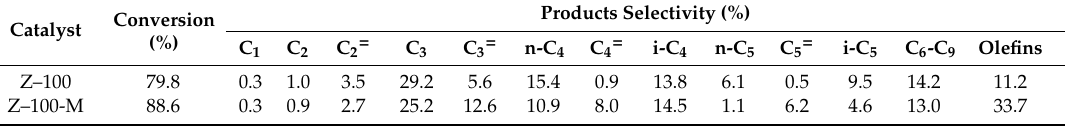
Table 4. The conversion of the catalytic cracking of n-decane and the products distribution a